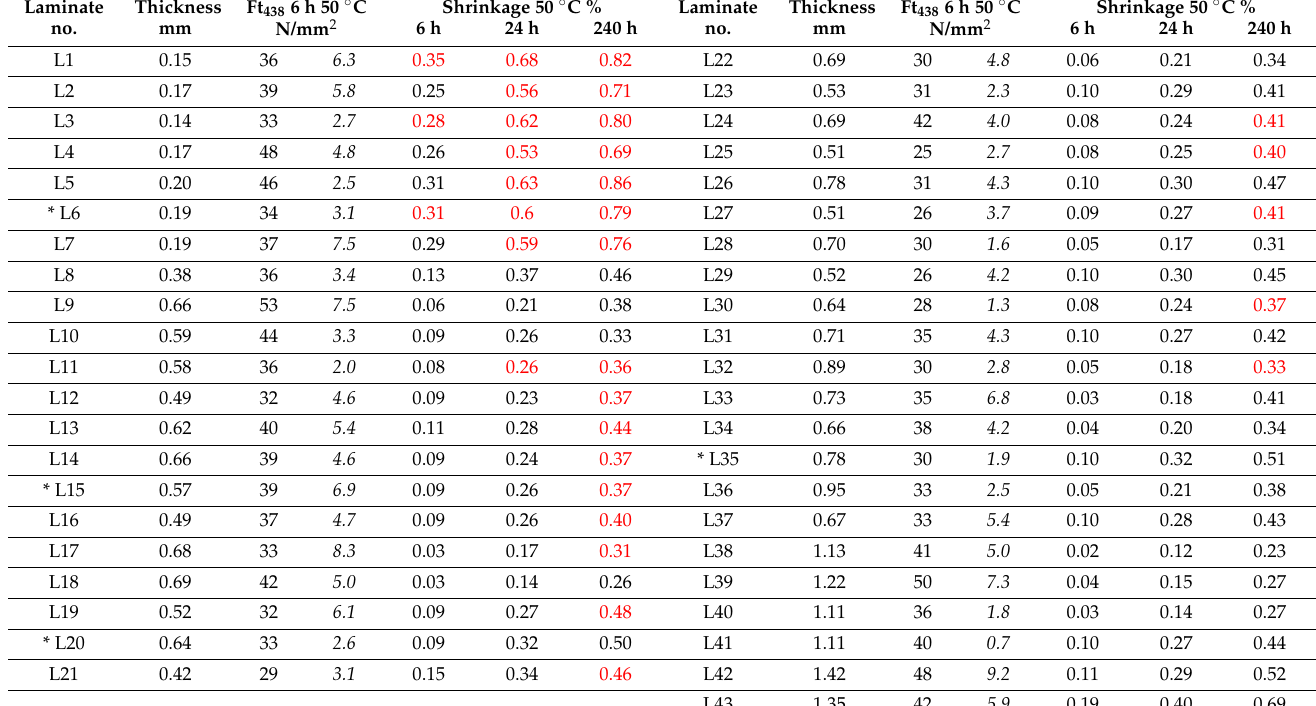
Table 1. The thickness (climate 23 ◦ C/50% RH), tensile strength Ft438 (span min-max in italics), and shrinkage of 43 laminates after storage at 50 ◦ C for 6, 24, and 240 h. Laminates that showed cracks after removal from the cramps are highlighted with red text. The four laminates chosen for the further test are highlighted by an